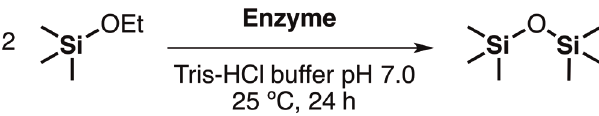
Figure 56 - Enzyme-catalyzed siloxane bond